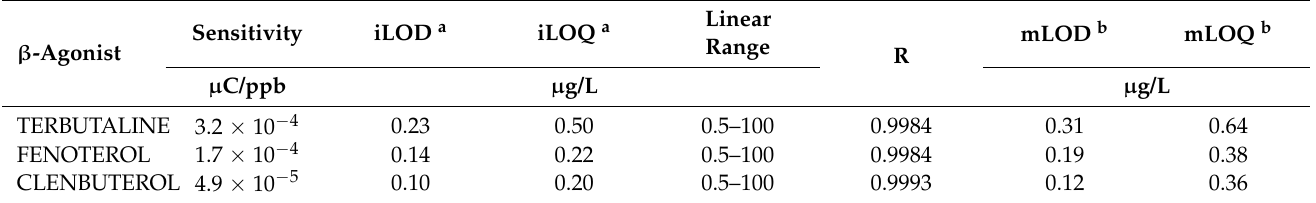
Table 2. Performance parameters of β -Agonists analyzed by LC-PAD at GCE.